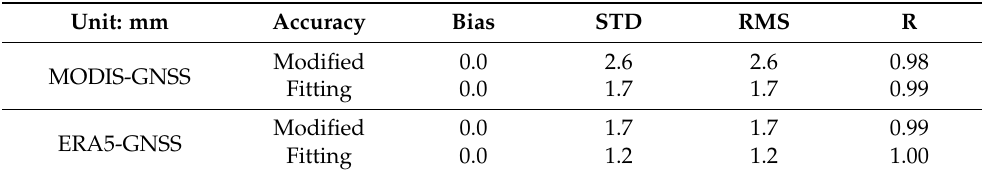
Table 4. Model performance based on monthly samples. Unit: